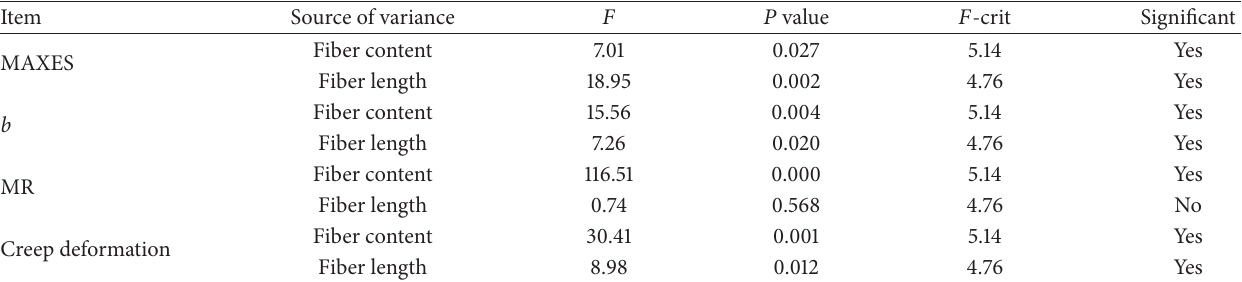
Table 6: Two-factor ANOVA on the properties of FRAC ( 𝛼 = 0.05